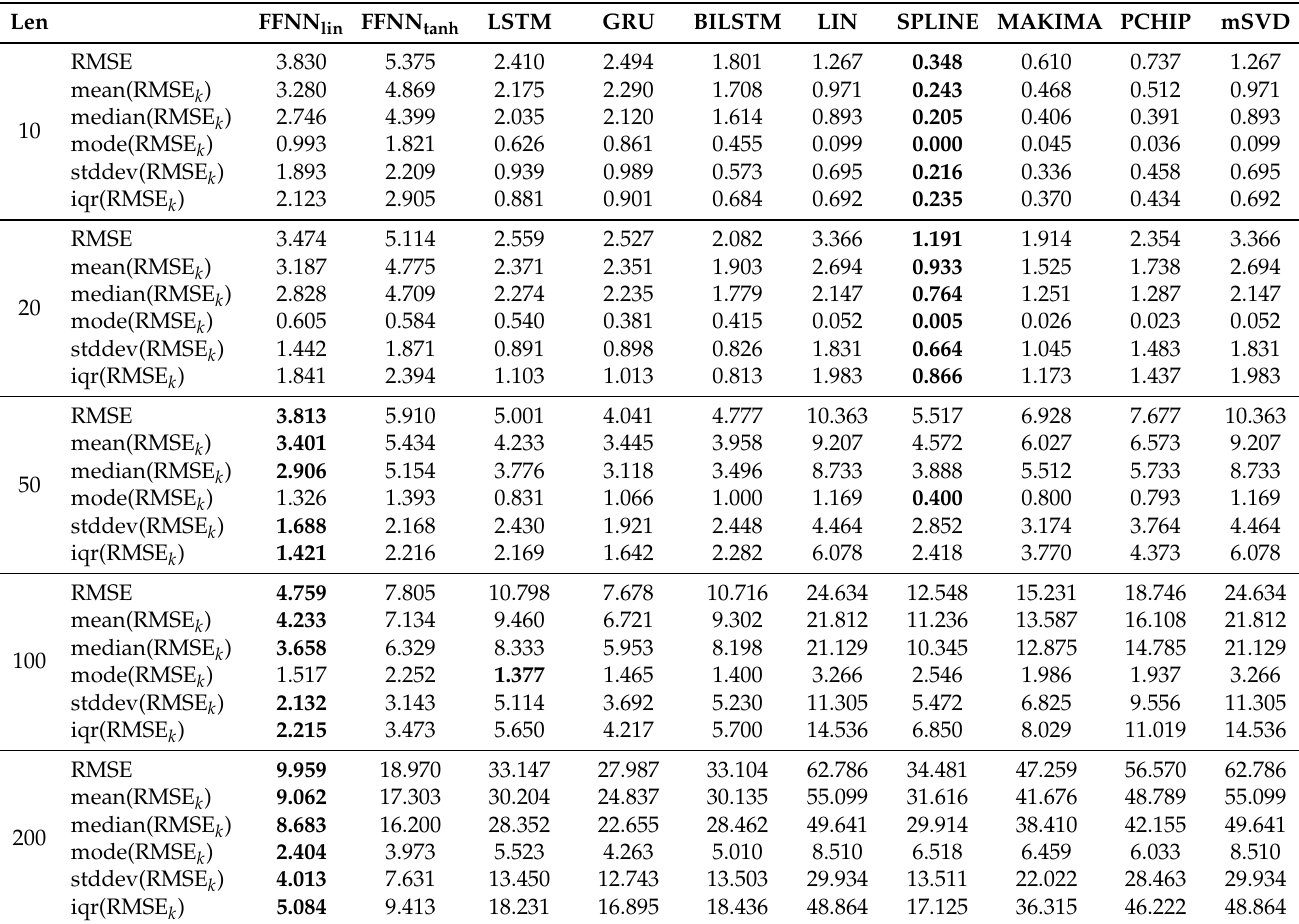
Table 3. Quality measures for the static (No. 1)